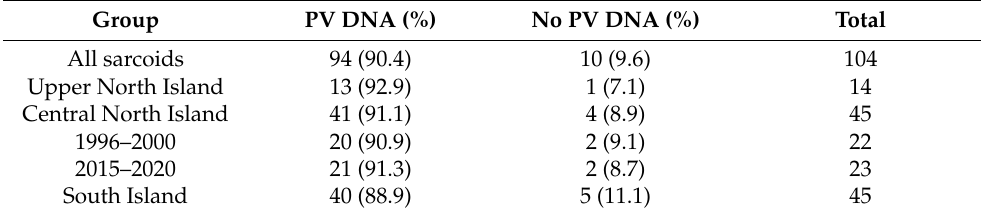
Table 2. Summary of regions and time periods from which the equine sarcoids were submitted. The number of sarcoids from each region and the time to contain detectible papillomaviral (PV) sequences is included. Group PV DNA (%) No PV DNA (%) Total All sarcoids